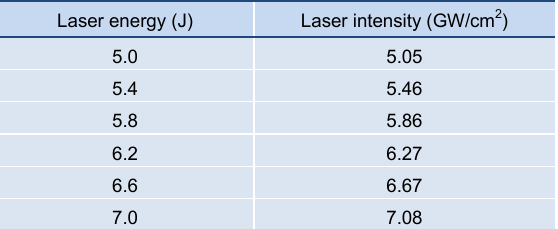
Table 3 | Laser intensity of each associated laser energy. Laser energy (J)